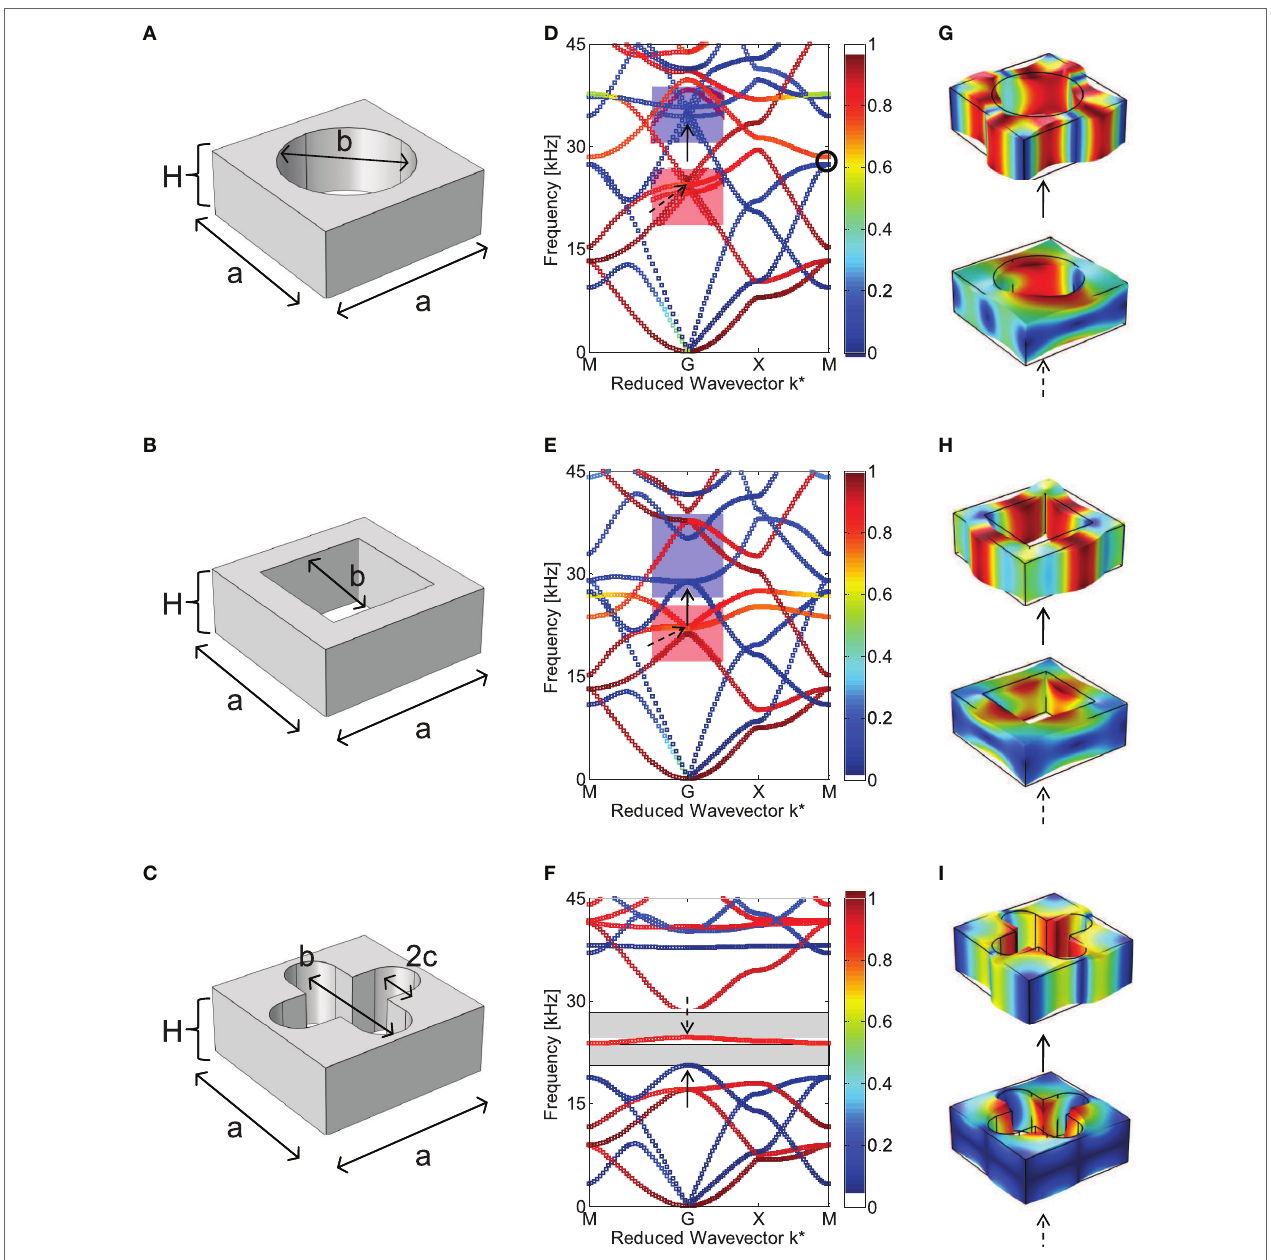
FigUre 1 | Unit cells made of (a) circular, (B) square, and (c) cross-like cavities in a PVC matrix and their corresponding band structures (D–F) and mode shapes (g–i) . The color of the curves indicates the mode polarization, ranging from pure in-plane (blue) to pure out-of-plane (red). On the other hand, blue and red in the mode shapes represent the zero and maximum displacement, respectively. Geometrical parameters are given in Table 1 and guarantee the same filling fraction of f f = 41% for all the three